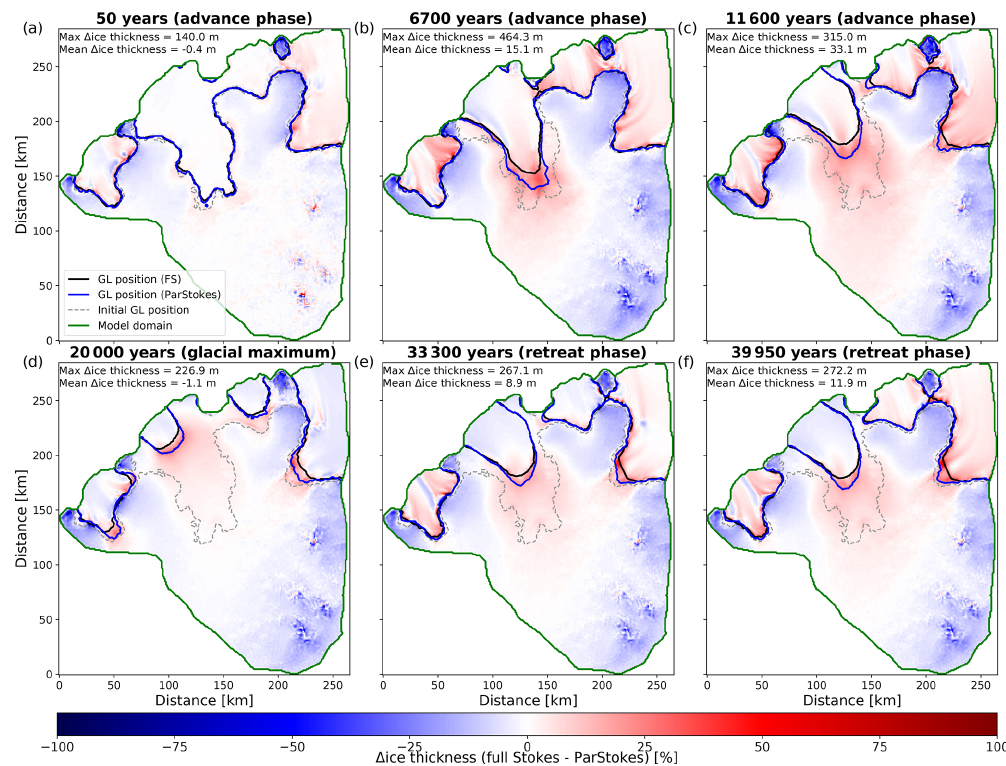
Figure 6. Differences in grounding-line position and ice thickness between the classic MUMPS and ParStokes solver setup for the hard-bed simulation at specific time